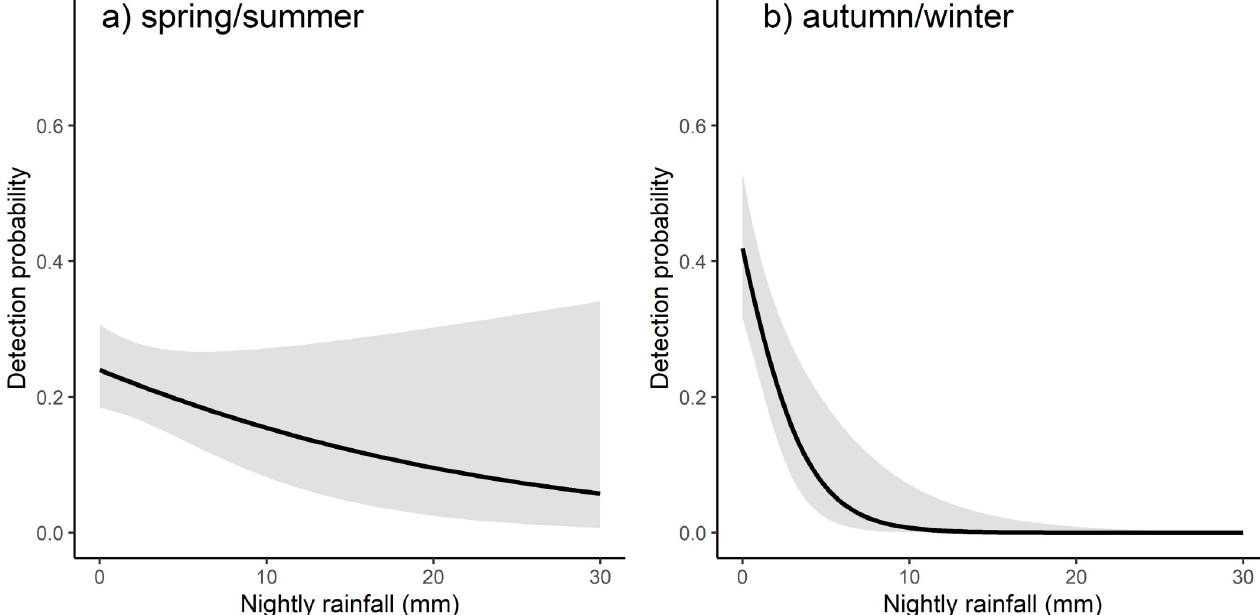
Fig 5. The influence of rainfall on detection probability of Yellow-bellied Gliders ( Petaurus australis ) during (a) spring/summer and (b) autumn/winter. 95% confidence intervals are shaded grey.